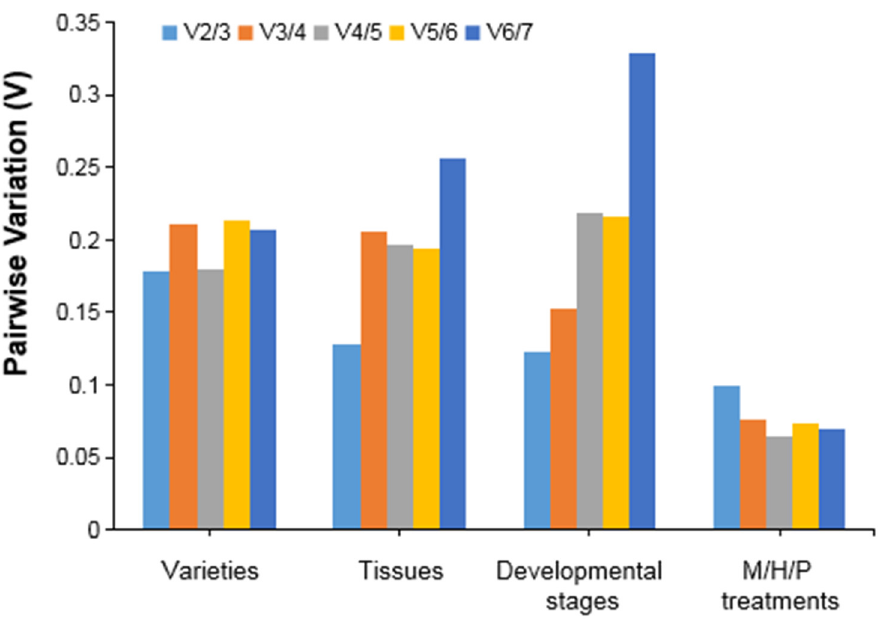
Figure 2. Pairwise variation (V) analysis of the seven candidate reference genes in all tested samples. M/H/P treatments means MT, HBR or PP treatments. M/H/P treatments means MT, HBR or PP